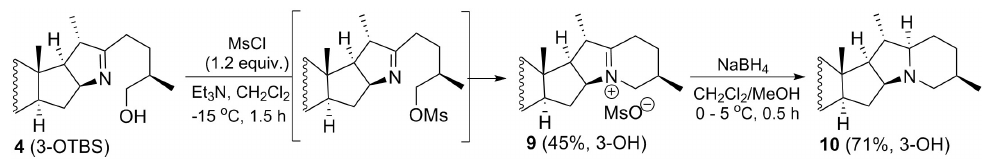
Scheme 3. Synthesis of 25-epidemissidine ( 10